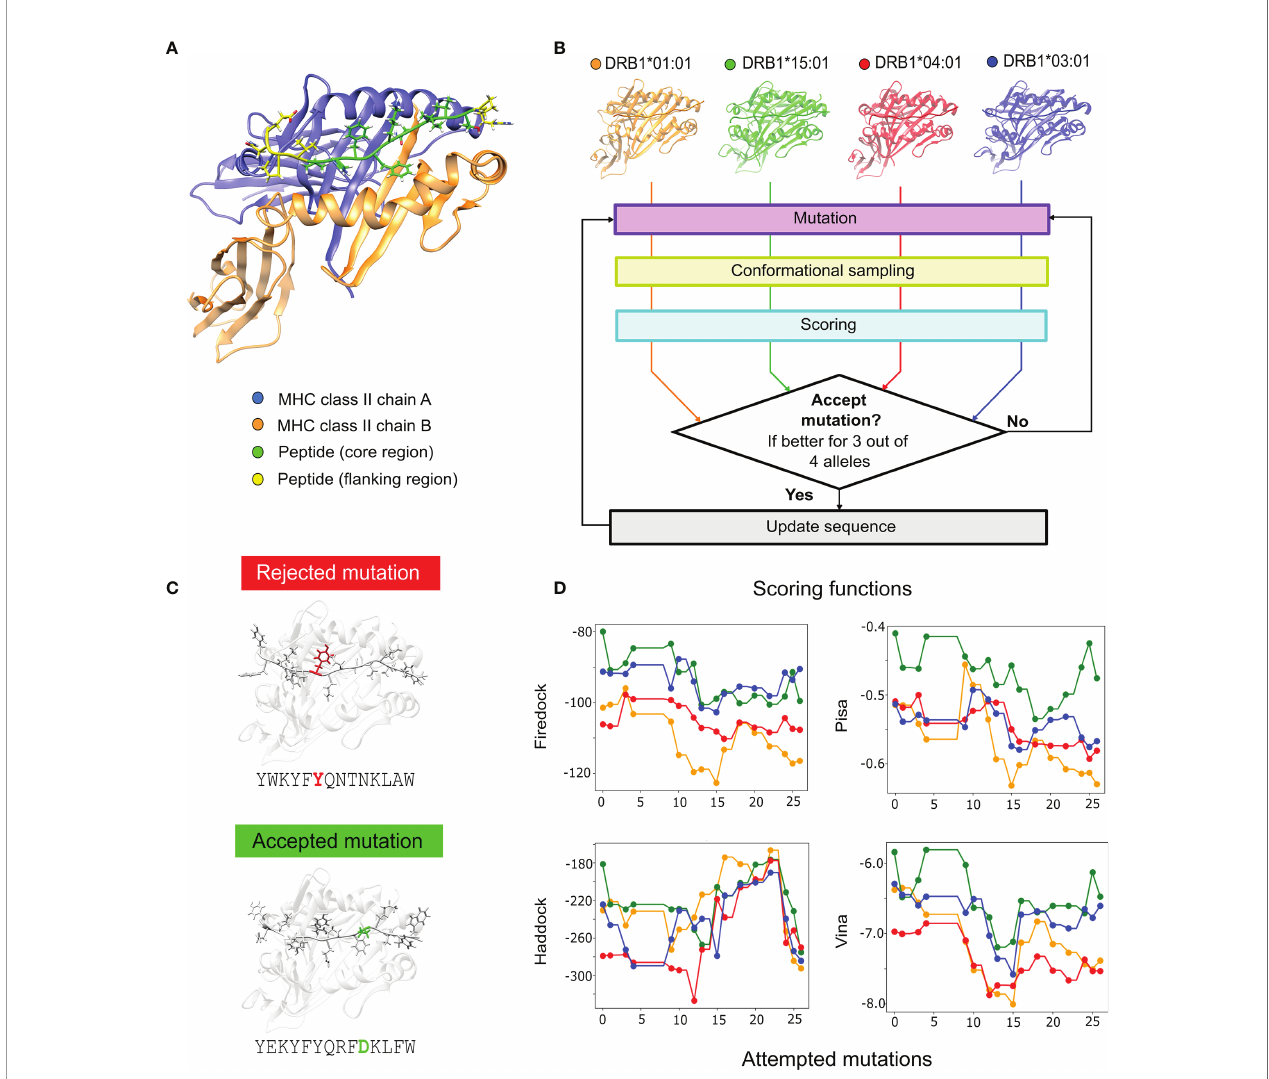
FIGURE 1 | Multiple-allele epitope engineering protocol. (A) MHC II receptor bound to a peptide, with chain a represented in blue, chain b in orange, the peptide core region in green and the peptide fl anking regions in yellow. (B) PanMHC-PARCE work fl ow for epitope optimization toward multiple alleles (DRB1*01:01 in orange, DRB1*15:01 in green, DRB1*04:01 in red and DRB1*03:01 in blue). First, the starting protein-peptide complexes are modelled. Then, a Monte Carlo algorithm is performed. At each step, a single-point mutation on the peptide is attempted. Then, parallel simulations of the mutated peptide with each allele are sampled with MD. The trajectory snapshots, for each allele, are scored with multiple scoring functions, and a consensus criterion is applied. The mutation is accepted if the scoring consensus is favorable for three out of the four alleles. (C) An example of a rejected mutation during the design is colored in red, and an accepted mutation colored in green. (D) Example of the evolution of the scoring results for the multiple-allele engineering of the P. vivax epitope for Firedock, Pisa, Haddock and Vina (see the Methods). The dots in the curves represent the mutations that are accepted and the colors of the different MHC alleles are based on panel (B)